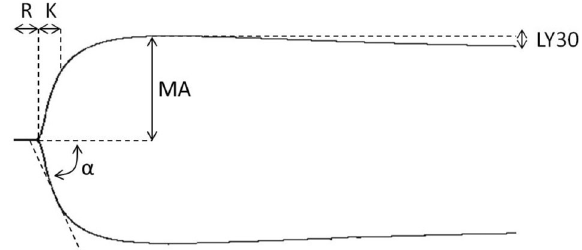
Fig. 2 Thromboelastography tracing from one of the donors in the study. R: Reaction time (measured in seconds) - the time from start of test to initial clot formation. K: Kinetics (measured in seconds) – the time to achieve a prede fi ned level of clot strength (amplitude of 20 mm). α : α -angle (measured in degrees) – the speed/rate at which the clot is formed. MA: Maximum amplitude (measured in mm) – the maximum strength of the formed clot. LY30: amplitude at 30 min (measured in % of MA) – the decrease in clot strength at 30 min, representing fi